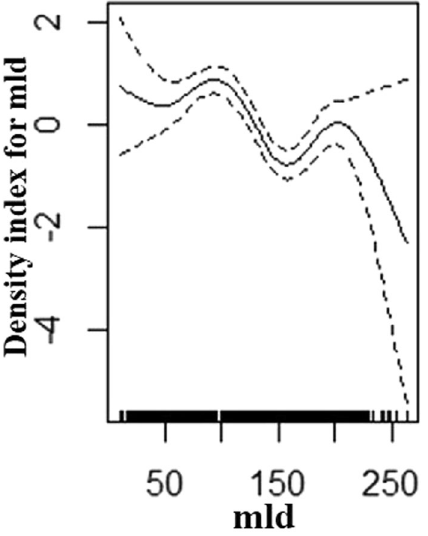
Figure 3. Shape of the functional form of the smoothed covariate (mixed layer depth) in the combined model. A zero on the Y axis corresponds to no effect of the covariate on the response variable (individual sightings). The dashed lines represent twice the standard error of the estimated curves (95% confidence bands). The locations of the observations are plotted as small ticks along the X axis. Figure generated using R version 3.3.1